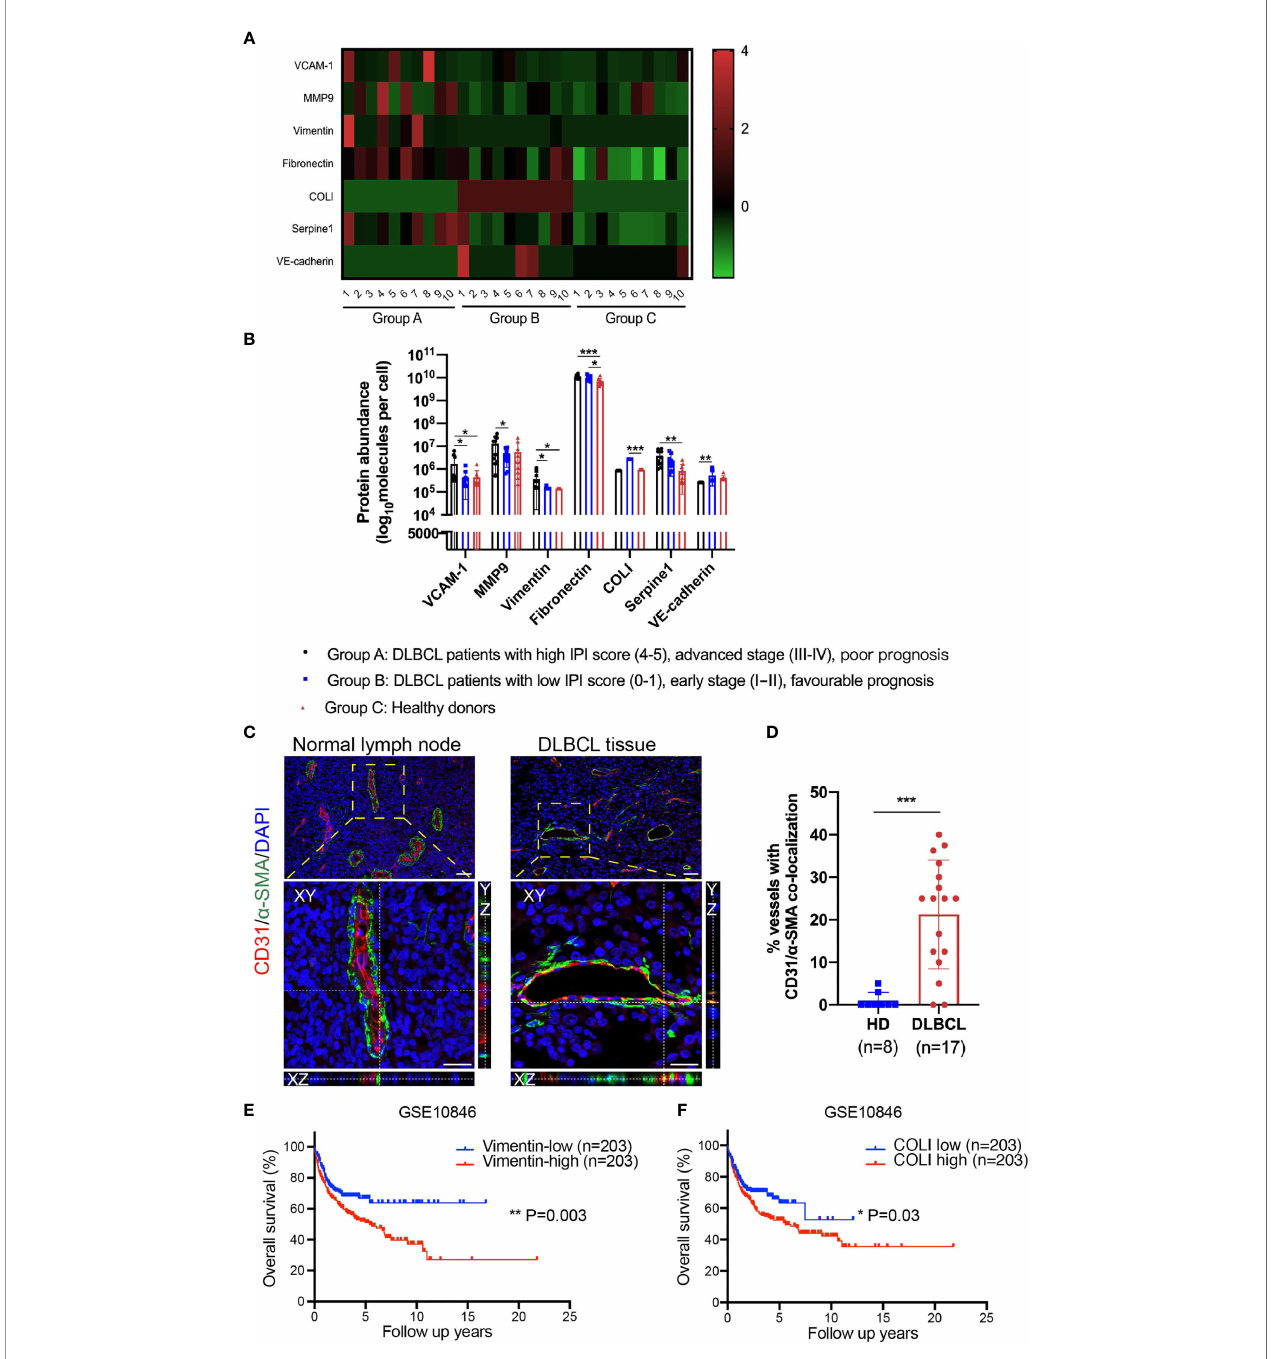
FIGURE 1 | EndMT was detected in DLBCL tissues, and EndMT markers were correlated with poor prognosis. (A, B) Proteomics analysis of serum exosomes from DLBCL patients and healthy donors (HD). Group A (n = 10), Group B (n = 10), and Group C (n = 10). (A) A heatmap showing differentially expressed EndMT marker proteins. Protein abundance was standardized by Z-score transformation. (B) Statistical analysis of differentially expressed EndMT marker proteins between 3 groups. (C) Representative orthogonal views of normal lymph nodes and DLBCL tissues double staining with endothelial cell marker CD31 (red) and mesenchymal cell marker a -SMA (green). Endothelial cells underwent EndMT co-expressed CD31/ a -SMA, giving rise to yellow staining. Top panel: scale bar, 50 m m; magni fi cation, ×200. Bottom panel: scale bar, 25 m m; magni fi cation, ×400. (D) The percentage of vascular endothelial cells displaying CD31/ a -SMA co-localization. (E, F) Kaplan – Meier analysis showed levels of vimentin and COLI were negatively associated with overall survival in DLBCL. Gene expression pro fi ling data of DLBCL patient samples were obtained from GEO/GSE10846. Error bars, SD. * p < 0.05, ** p < 0.01, *** p < 0.001. EndMT, endothelial-to-mesenchymal transition; DLBCL, diffuse large B-cell lymphoma; a -SMA, a -smooth muscle actin; COLI, collagen type I; GEO, Gene Expression